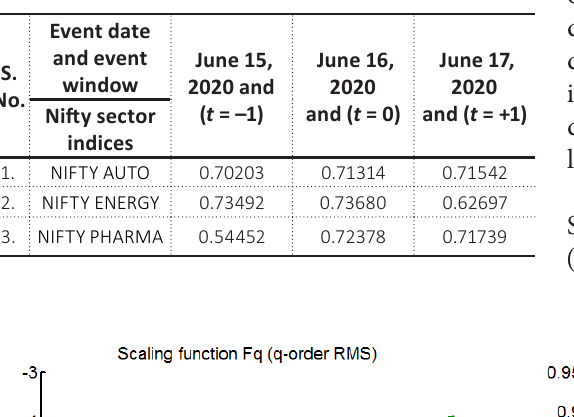
Table 5. Illustrating results of Hurst exponent ( H from MFDFA analysis